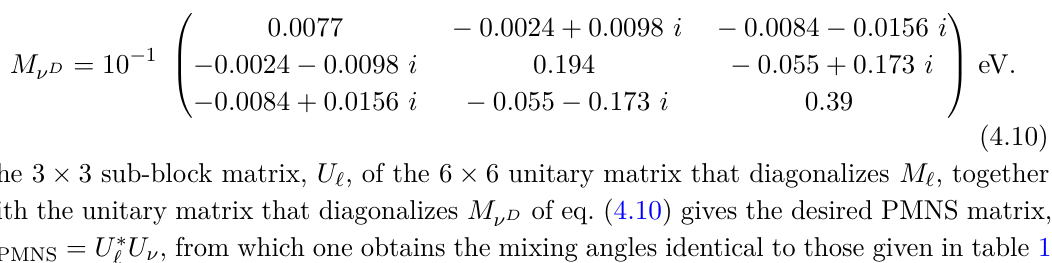
Table 2. Model parameters that give neutrino oscillation fit of table 1. Here M P /M W mass matrix of eq. (4.1) for this choice of input parameters is given by